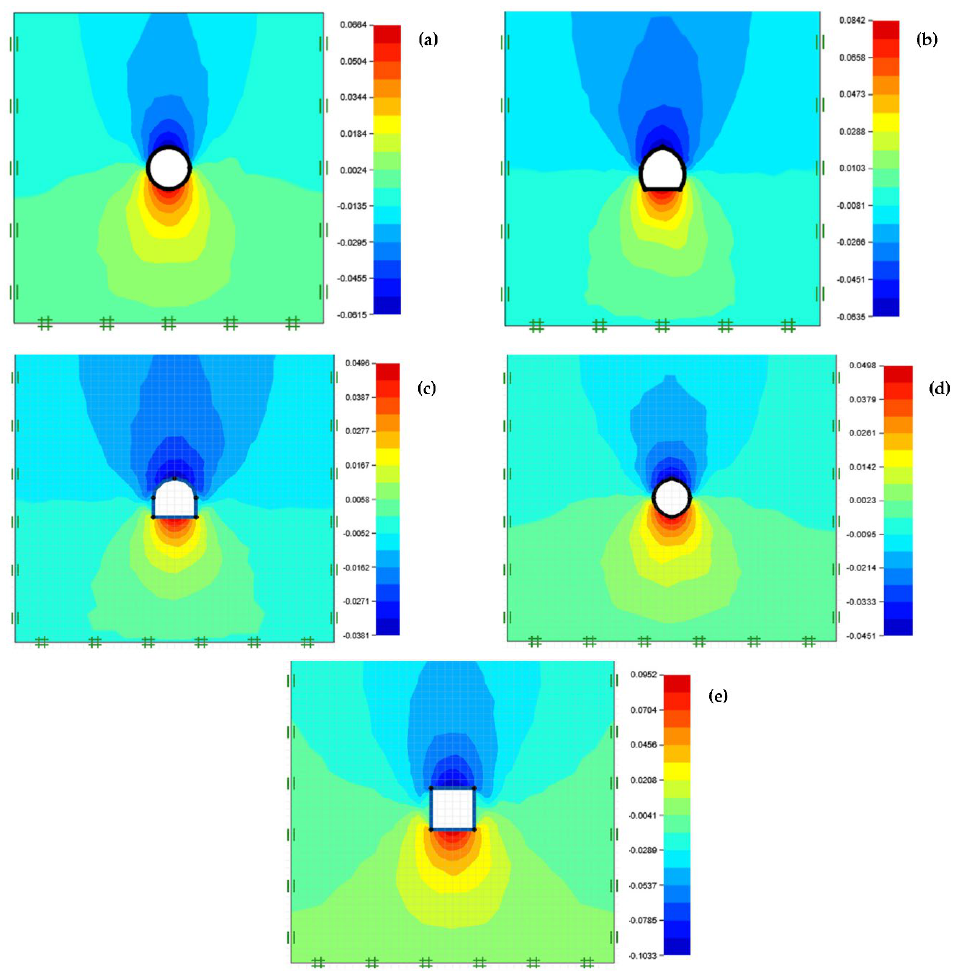
Figure 13. Vertical displacement in soil having ( a ) circular-, ( b ) arch-, ( c ) horseshoe-, ( d ) elliptical-, and ( e ) square-shaped openings.